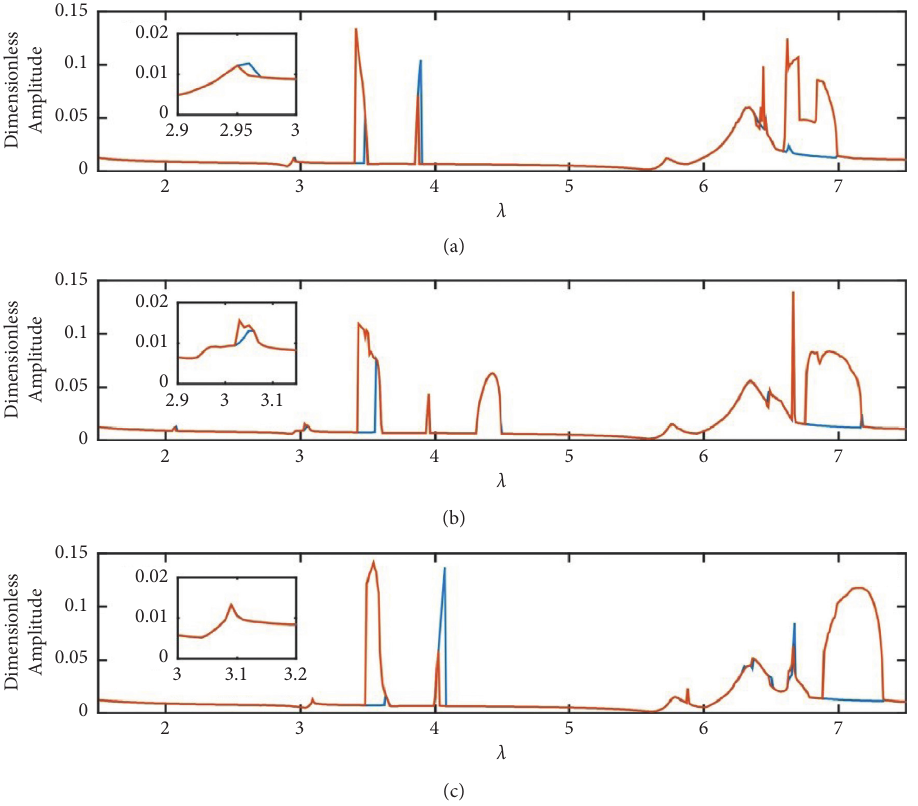
Figure 12: The amplitude-frequency curves of responses of disc in horizontal direction when (a) N (blue line means run-up process and brown line means run-down process).